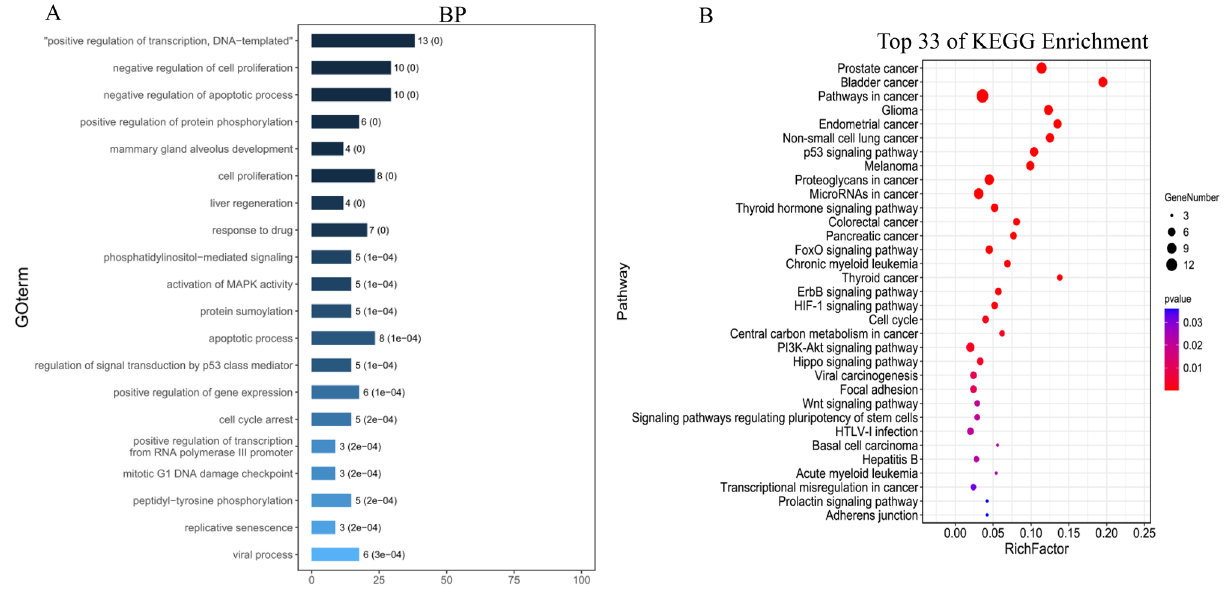
Figure 3. Functional analysis of identified compound-related targets. ( A ) Enrichment analysis of Gene Ontology (GO) biological processes of anti-cancer target genes of active ingredients of CKI. ( B ) Kyoto Encyclopedia of Genes and Genomes (KEGG) pathways related to anti-cancer targets of CKI. The image was created using the OmicShare tools, a free online platform for data